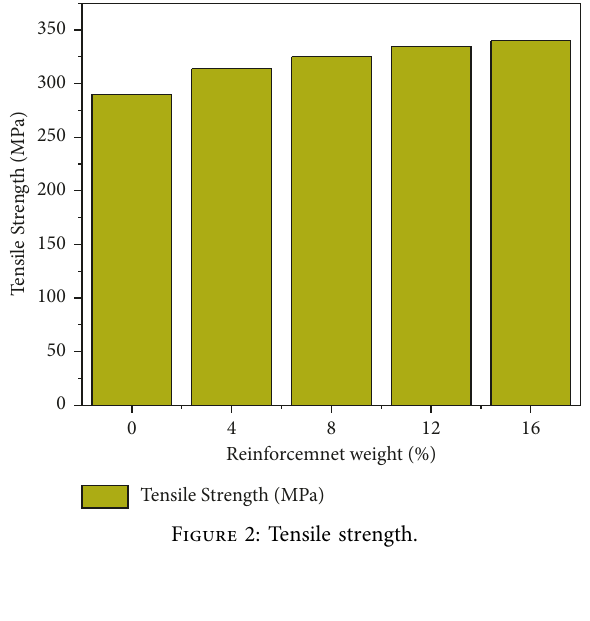
Figure 4: XRD evaluation of AA7075